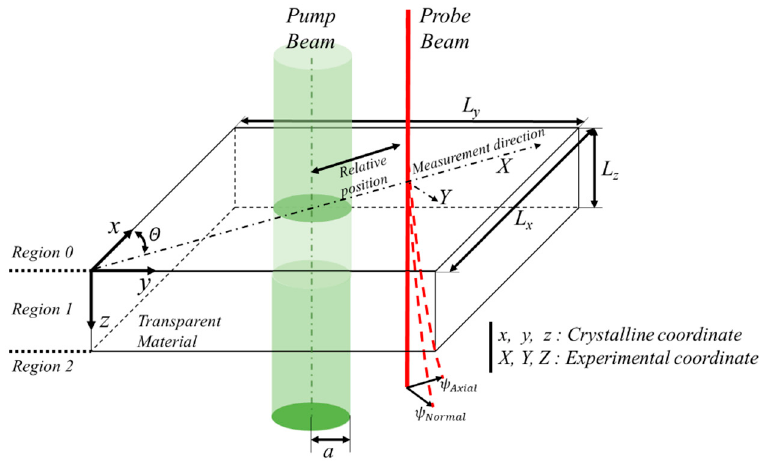
Figure 3. Schematic diagram of collinear deflection analysis.